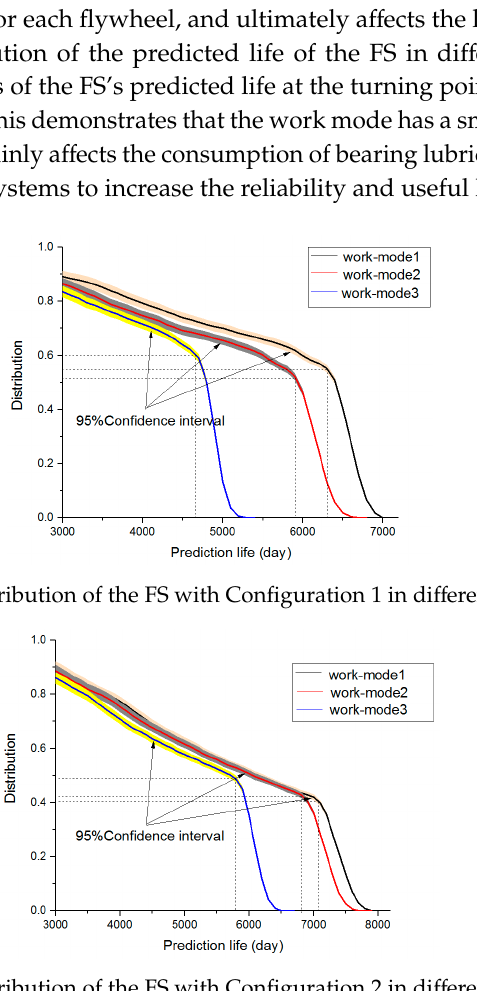
Figure 22. Life distribution of the FS with Configuration 2 in di ff erent work